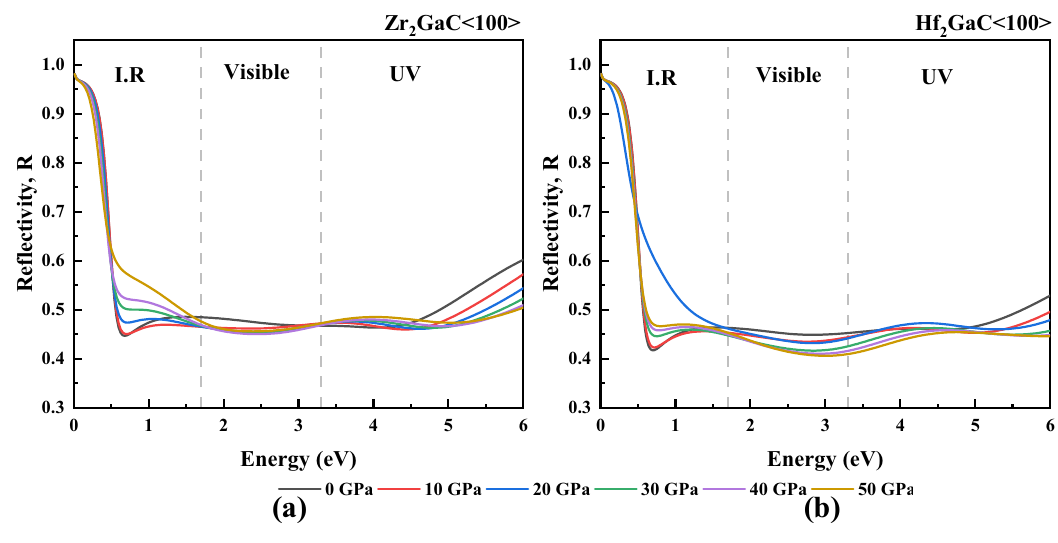
Figure 20. Reflectivity of M 2 GaC MAX phases (M = Zr, Hf) for <100> polarization at 0–50 GPa